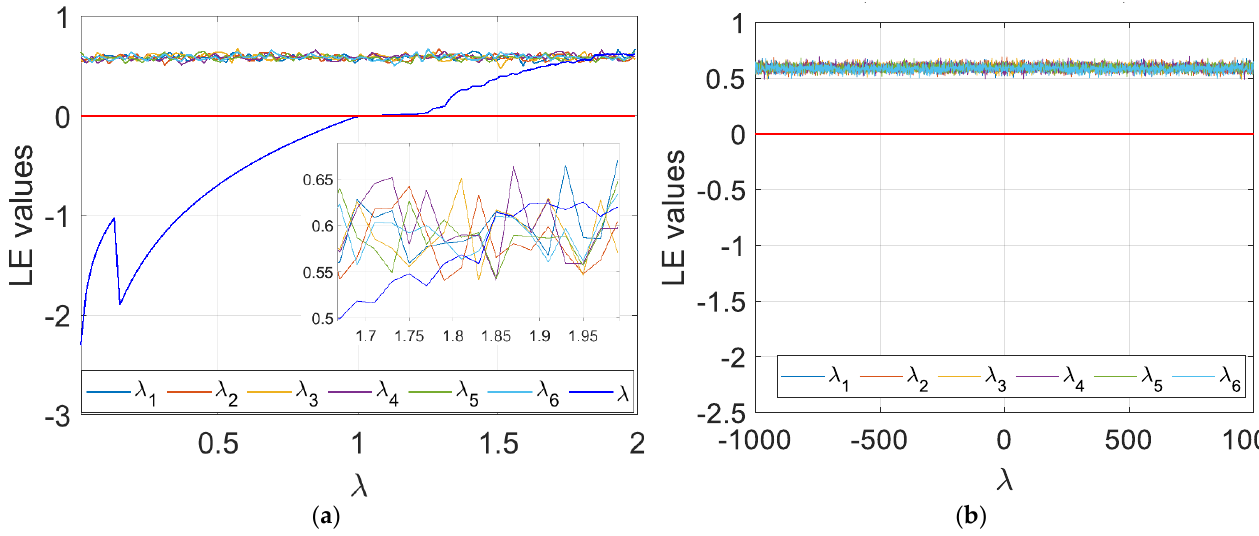
Figure 2. ( a ) LE values corresponding to TM and MTM parameters within the range [0, 2] and ( b ) LE values of MTM in the range [ − 1000,